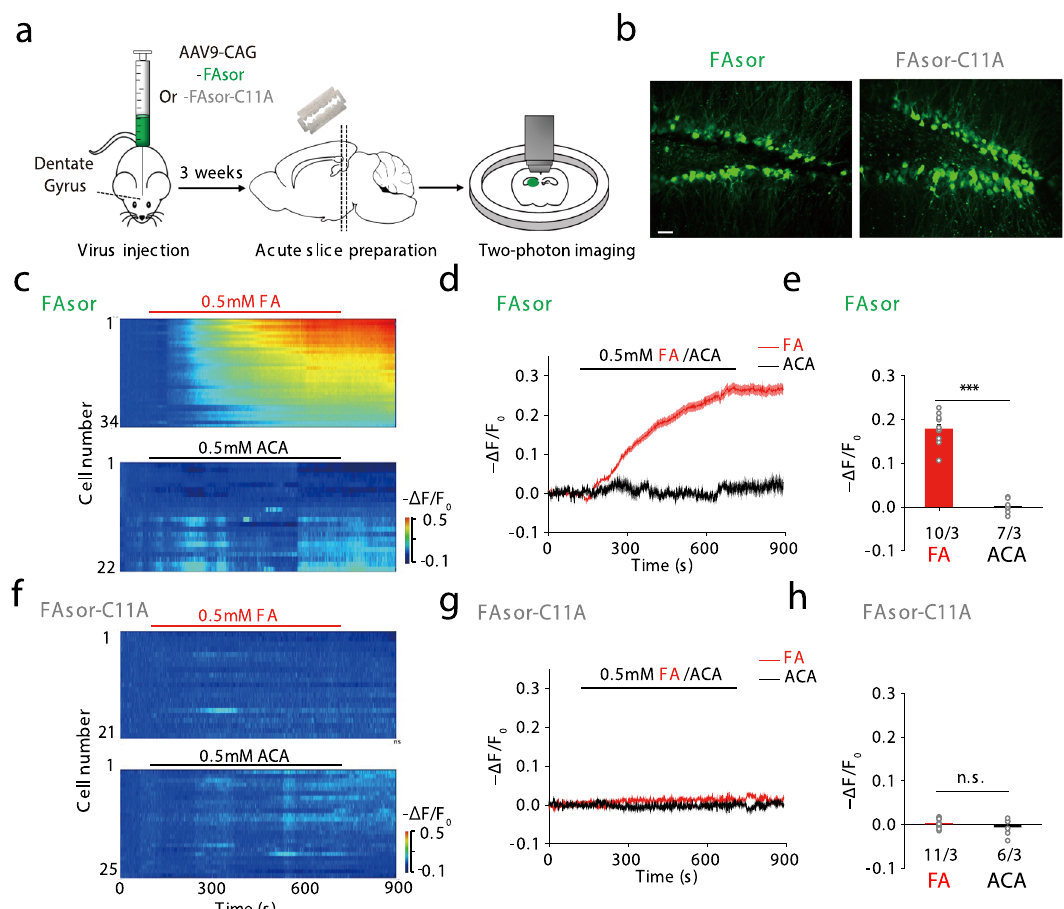
Fig. 5 Visualization of FA in mouse acute brain slices by two-photon imaging of FAsors. a Schematic illustration of the work fl ow. AAVs containing FAsor or FAsor-C11A were injected into the dentate gyrus of mice, and acute brain slices were prepared 3 weeks after viral expression, which were placed under two-photon microscope for imaging. b Expression of FAsor and FAsor-C11A in pyramidal neurons of the dentate gyrus in acute brain slices. The two-photon laser was set at 880 nm for excitation. Scale bars: 20 μ m. c – e The fl uorescence responses of FAsor-expressing neurons to exogenous perfusion of 0.5 mM formaldehyde (FA) (upper, red), or 0.5 mM acetaldehyde (ACA, lower, black) as a control. The responses of individual cells in one single slice were plotted in pseudo-color in c , and their averaged time-dependent traces were shown in d . The group data of responses in multiple slices of different animals were summarized in e with data shown in mean ± SEM. Unpaired two-sided student ’ s t- test was performed. n = 10 slices from 3 mice and 7 slices from 3 mice, for FA and ACA, respectively. *** P < 0.001 ( P = 3.19 × 10 − 7 ). f – h Similar as c – e , except the fl uorescence responses of FAsor-C11A-expressing neurons were summarized and plotted. Data are shown in mean ± SEM in h . Unpaired two-sided student ’ s t -test was performed. n = 11 slices from 3 mice and 6 slices from 3 mice, for FA and ACA, respectively. n.s. no signi fi cance ( P =